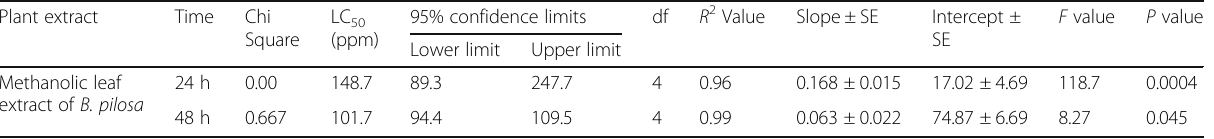
Table 8 Log probit and regression analysis of third larval instars of C. quinquefasciatus in different concentrations of methanolic extract of B. pilosa for 24 h and 48 h Plant extract Methanolic leaf extract of B.